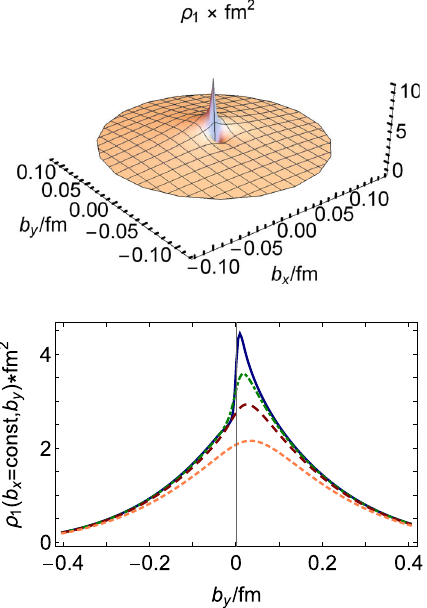
Fig. 7 ρ 1 ( b ⊥ , s ⊥ ∝ ˆ x ) , Eq. (65), light-front transverse-spin distri- bution of dressed valence quarks within the pion. Upper panel – Full three-dimensional image; and lower panel – Slices at constant b x / fm: solid blue – b x = 0 . 01; dot-dashed green – b x = 0 . 025; dashed dark- red – b x = 0 . 05; and short-dashed orange – b x = 0 . 1. In both panels, the scale is ζ H , Eq. (61)